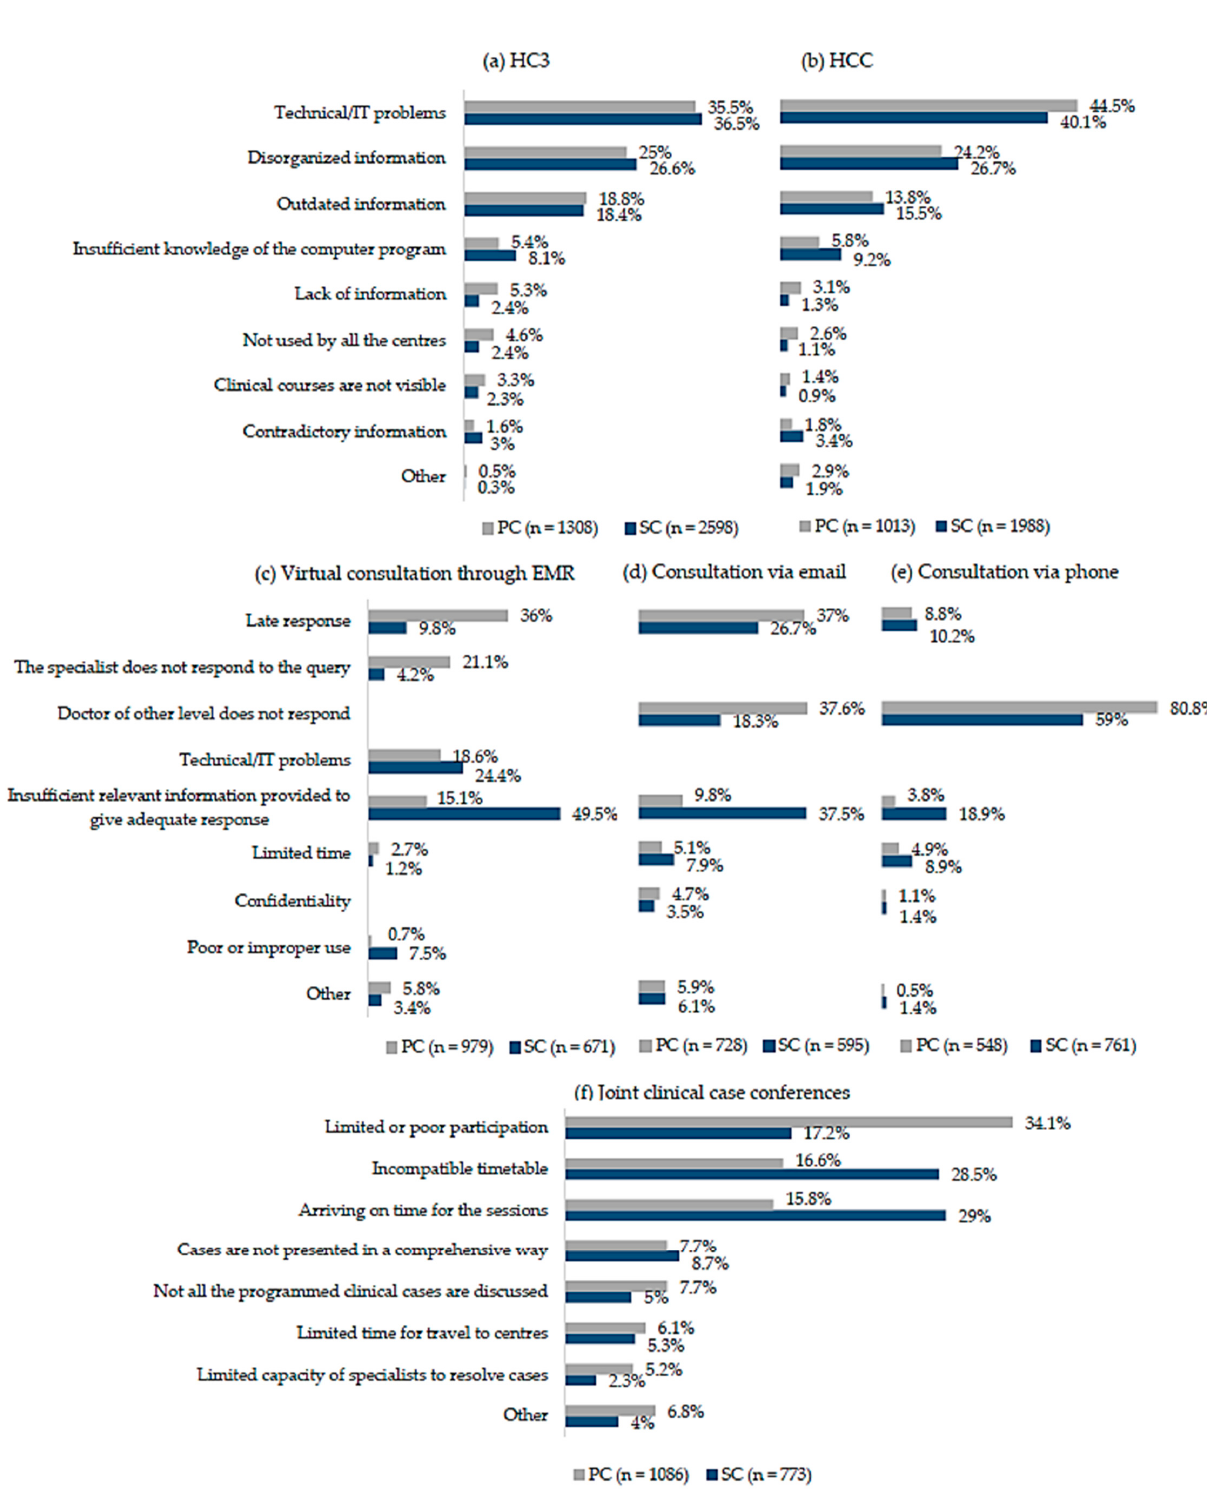
Figure 1. Difficulties in use of cross-level clinical coordination mechanisms, by level of care: ( a ) Shared EMR of Catalonia (HC3); ( b ) Shared EMR of the organization (HCC); ( c ) Virtual consultation through EMR; ( d ) Consultation via email; ( e ) Consultation via phone; ( f ) Joint clinical case conferences; n : total of answers.